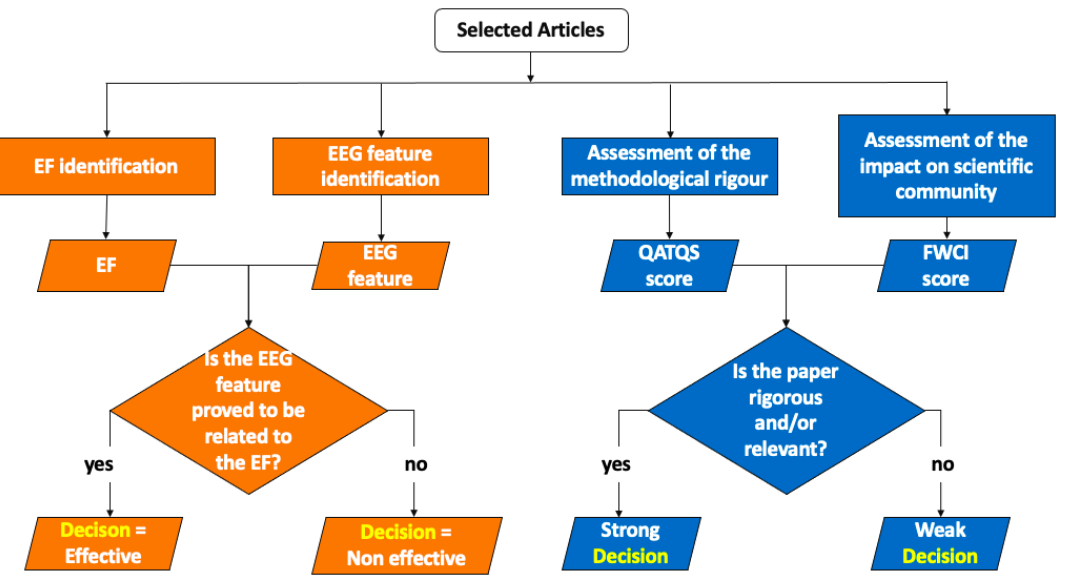
Figure 2. The flow-chart of the article analysis. Each article is subjected to two types of analysis in parallel: (i) the analysis to extract relationships between EEG features and executive functions (in orange) and (ii) the analysis to assess the rigor and scientific impact of the study (in